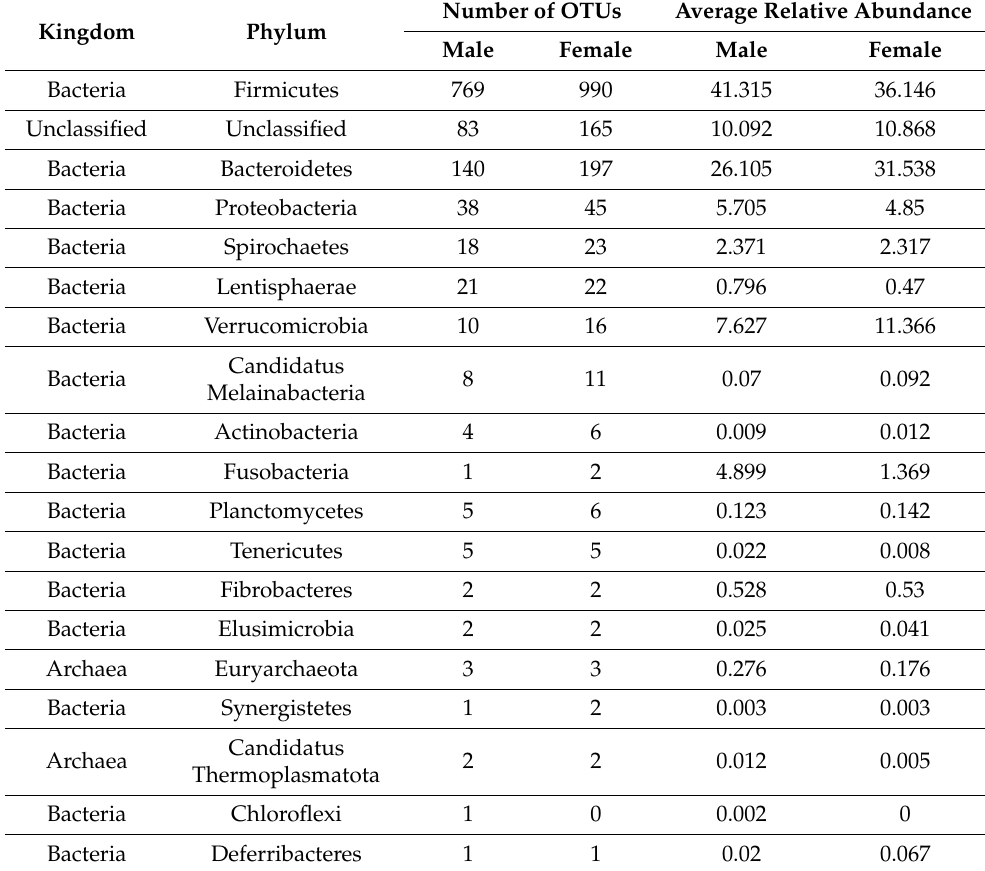
Table 2. Average relative abundance of bacteria and archaea phyla found in fecal samples and phylum level composition of OTUs. Values were presented as